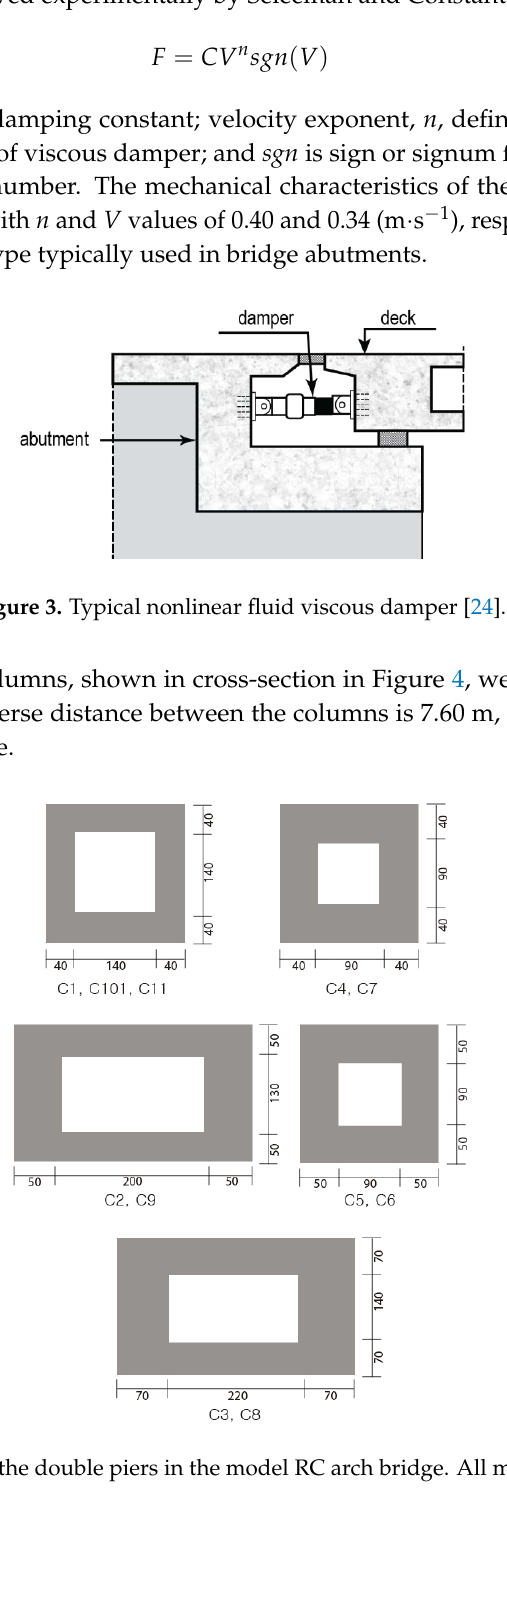
Figure 4. Cross section of the double piers in the model RC arch bridge. All measurements are in cm.